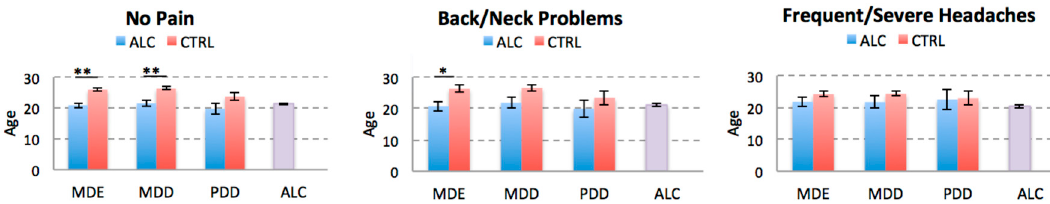
Figure 4. Comparison of the Age of Onset of Depressive Disorders. The plots represent the average age of onset of each depressive disorder for the ALC and CTRL cohorts stratified for the history of chronic pain. For comparison, average age of alcohol abuse onset is also presented (last column).